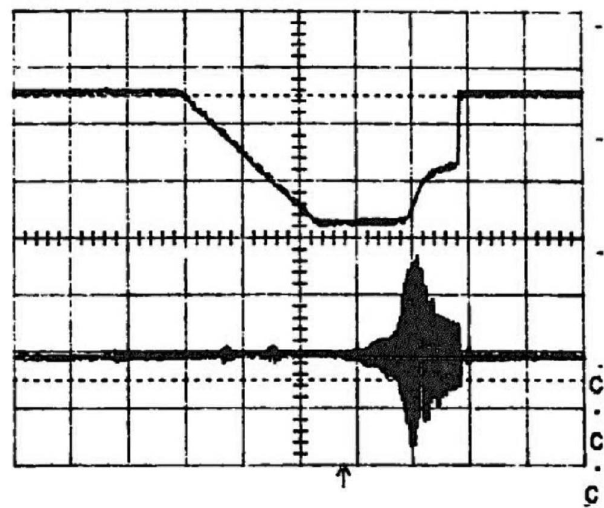
FIG. 6. Observation of coherent vertical oscillation and the resulting beam loss at the Los Alamos PSR instability around 1990 [23]; beam current (top curve shows inverted signal from beam current monitor) and vertical oscillations (bottom curve is the simultaneous signal from a vertical difference monitor); horizontal axis is time with 200 (cid:7) s = div